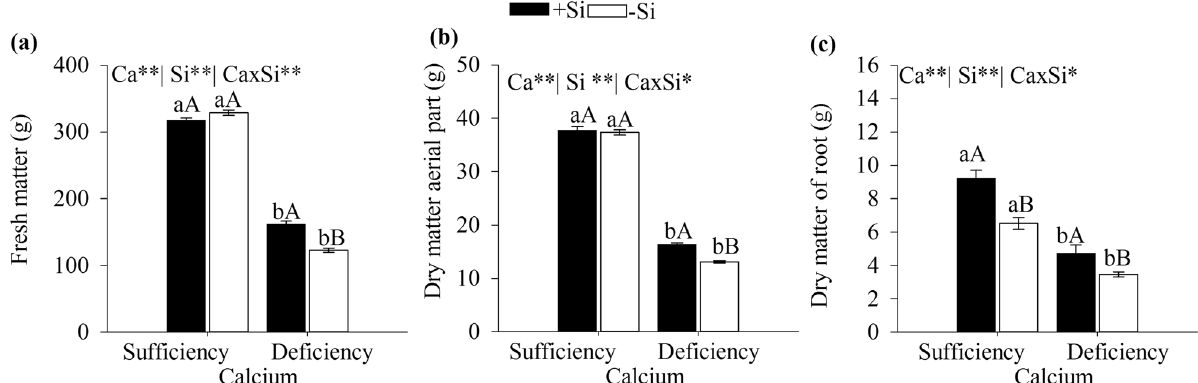
Figure 4. Fresh matter of the aerial parts ( a ), dry matter of the aerial parts ( b ) and roots ( c ) of cabbage under Ca sufficiency and Ca deficiency, with (− Si) and without added Si (+ Si). F test was applied: *( p ≤ 0.05) and **( p ≤ 0.01). The student t means comparison test was applied. Lowercase letters (a, b) indicate significant differences to calcium within the same level as Si ( p < 0.05). Uppercase letters ( A , B ) indicate significant differences for silicon within the same level as Ca ( p < 0.05). The bars represent the mean standard error. n = 5.